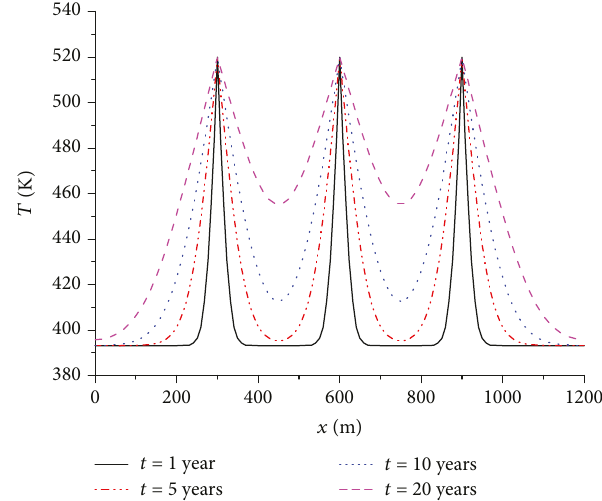
Figure 7: Temperature distribution pro fi le in the thermal-stimulated shale